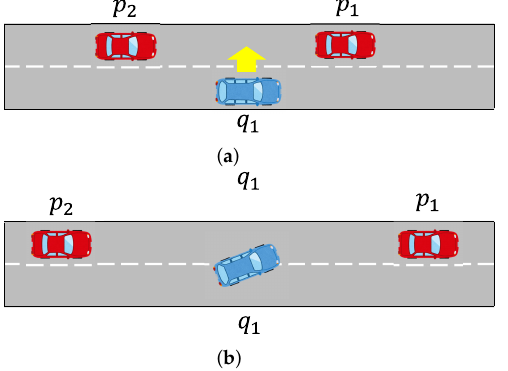
Figure 3. ( a ) A typical scenario for cooperative lane change request, and ( b ) the expected scenario after